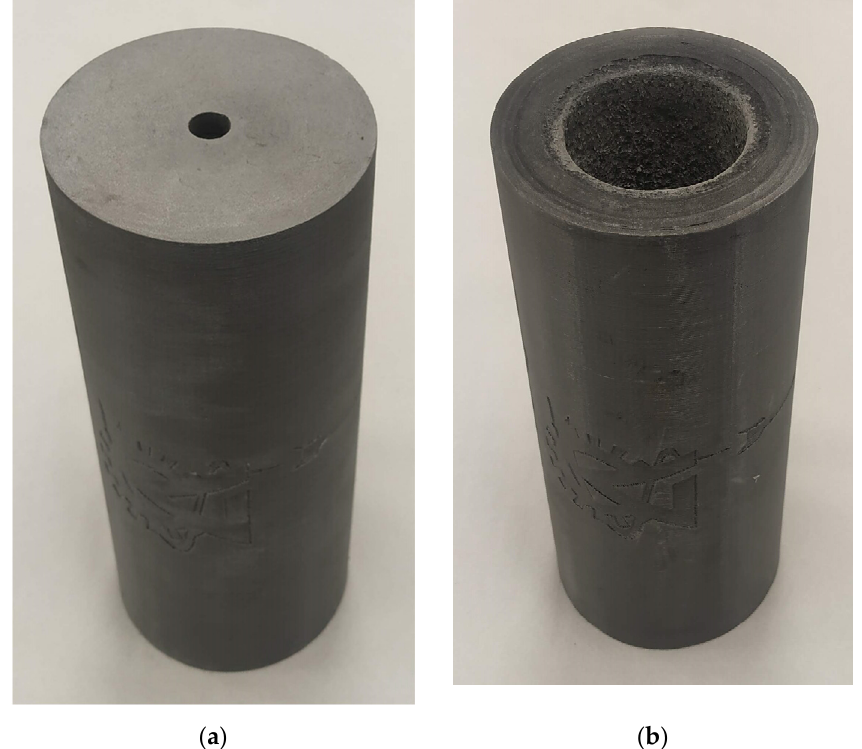
Figure 4. A polyester fuel grain containing 30% aluminum (as a hydro-reactive fuel): ( a ) before and ( b ) after static firing. Table 2. Weight percent of polyester, magnesium, and aluminum at the different fuel compositions tested.